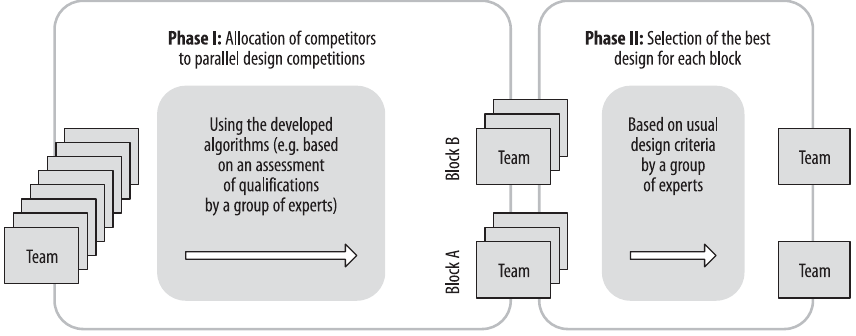
Figure 1. The basic idea of multi-target